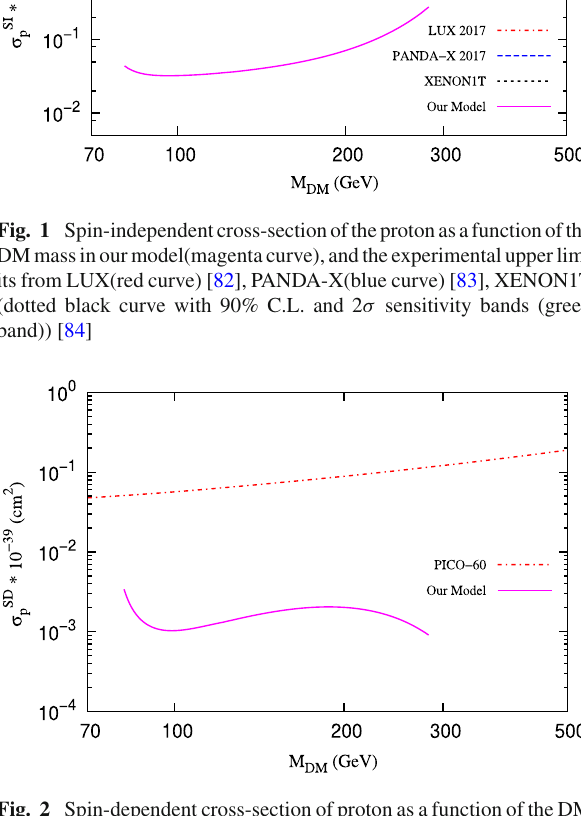
Fig. 2 Spin-dependent cross-section of proton as a function of the DM mass in our model (magenta curve), and the experimental upper bound from PICO-60 [85] experiment